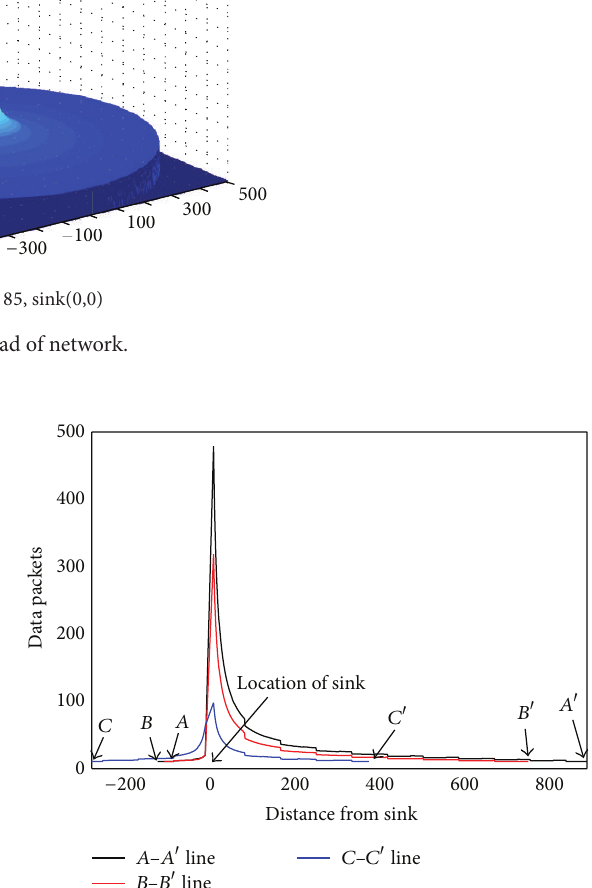
Figure 5: Data load in different distances from sink in different